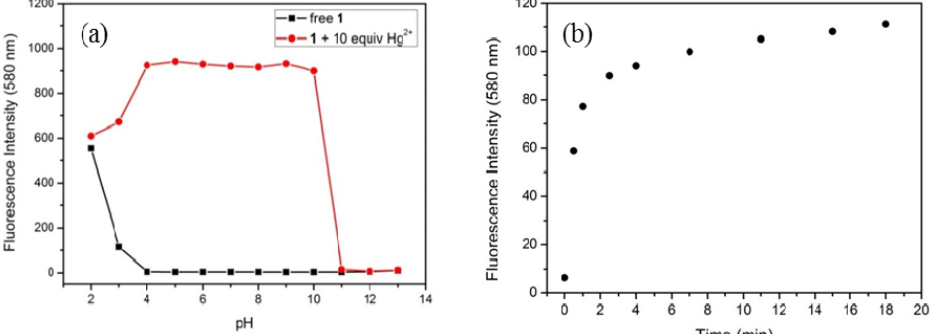
Figure 7. Fluorescence intensity of 1 at 580 nm (5 μ M, λ (95/5, v / v ) ( a ) with and without Hg 2+ ion (50 μ M) as a function of pH and ( b ) upon addition of Hg 2+ ion (50 μ M) over